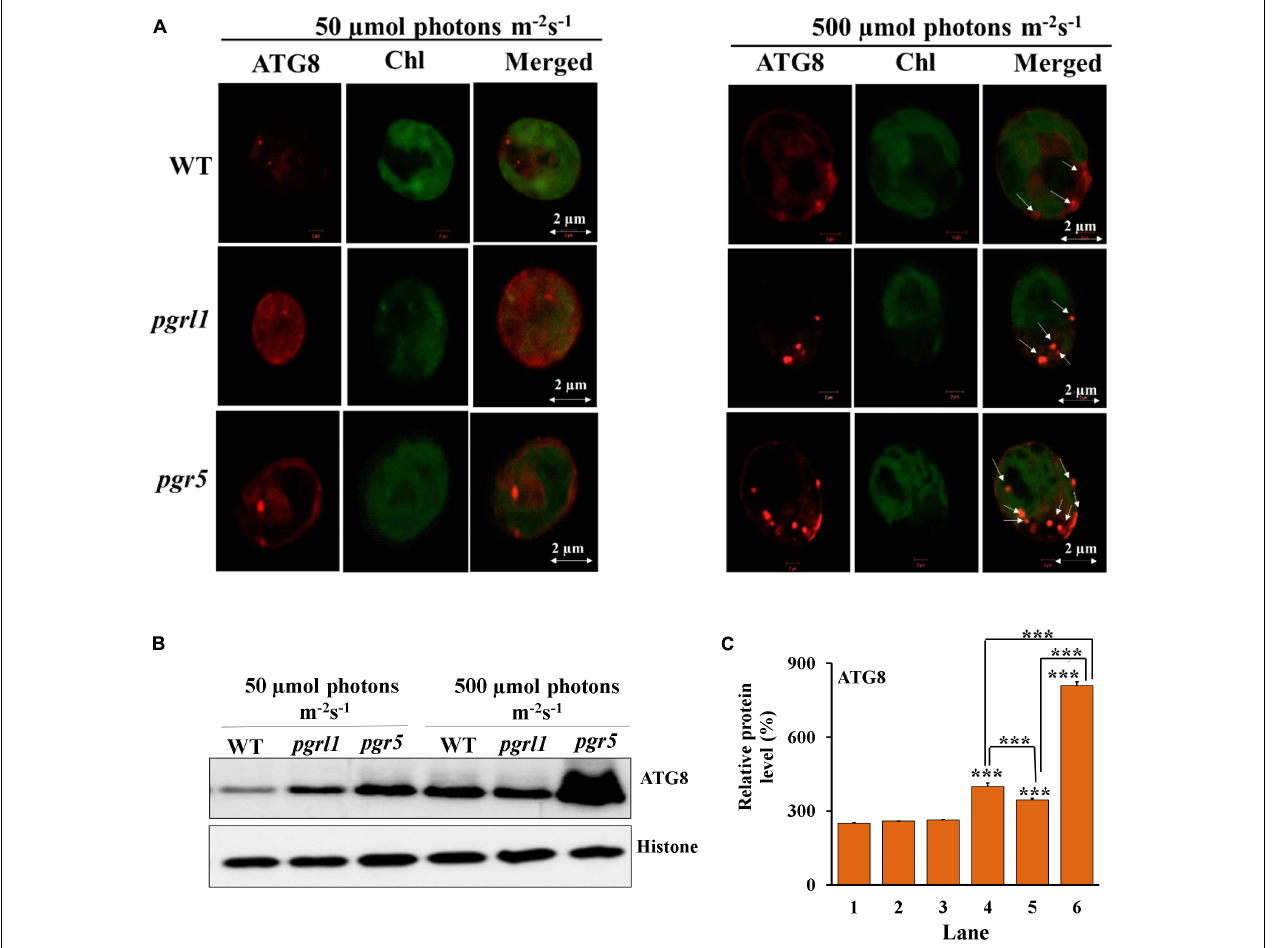
FIGURE 4 | Autophagy (ATG)8 accumulation in C. reinhardtii cells under high light conditions. (A) Autophagy induction in C. reinhardtii cells collected at phase cells (3.0 × 10 6 cells) grown in tris-acetate phosphate (TAP) medium under continuous light of 50 and 500 µ mol photons m − 2 s − 1 . Samples were collected after 3rd day and immunoassay with anti-ATG8 antibody (in red). Chloroplasts were visualized by auto-fluorescence (in green). The images were collected with three individual measurements for all the conditions ( n = 3). The image was taken using a Zeiss confocal microscope. Scale bars = 2 µ m. (B) Protein identification by western blot. Western blot analysis of ATG8 evaluated from 3rd-day cells under the normal (50 µ mol photons m − 2 s − 1 ) and high (500 µ mol photons m − 2 s − 1 ) light condition, and each lane 5 µ g protein were loaded. Autophagy (ATG)8-PE protein was resolved on 15% Bis-Tris gel in denaturing conditions. Histone (H3) was used as a loading control. All the blots were conducted in three independent experiments ( n = 3) and obtained similar results. (C) Quantification of the immunoblots was done by ImageJ. The measurements were repeated with three individual cultures, and error bars represented the mean ± SD ( n = 3). Statistical significance was analyzed using one-way ANOVA with Tukey test and the p -value obtained are indicated (*** p <